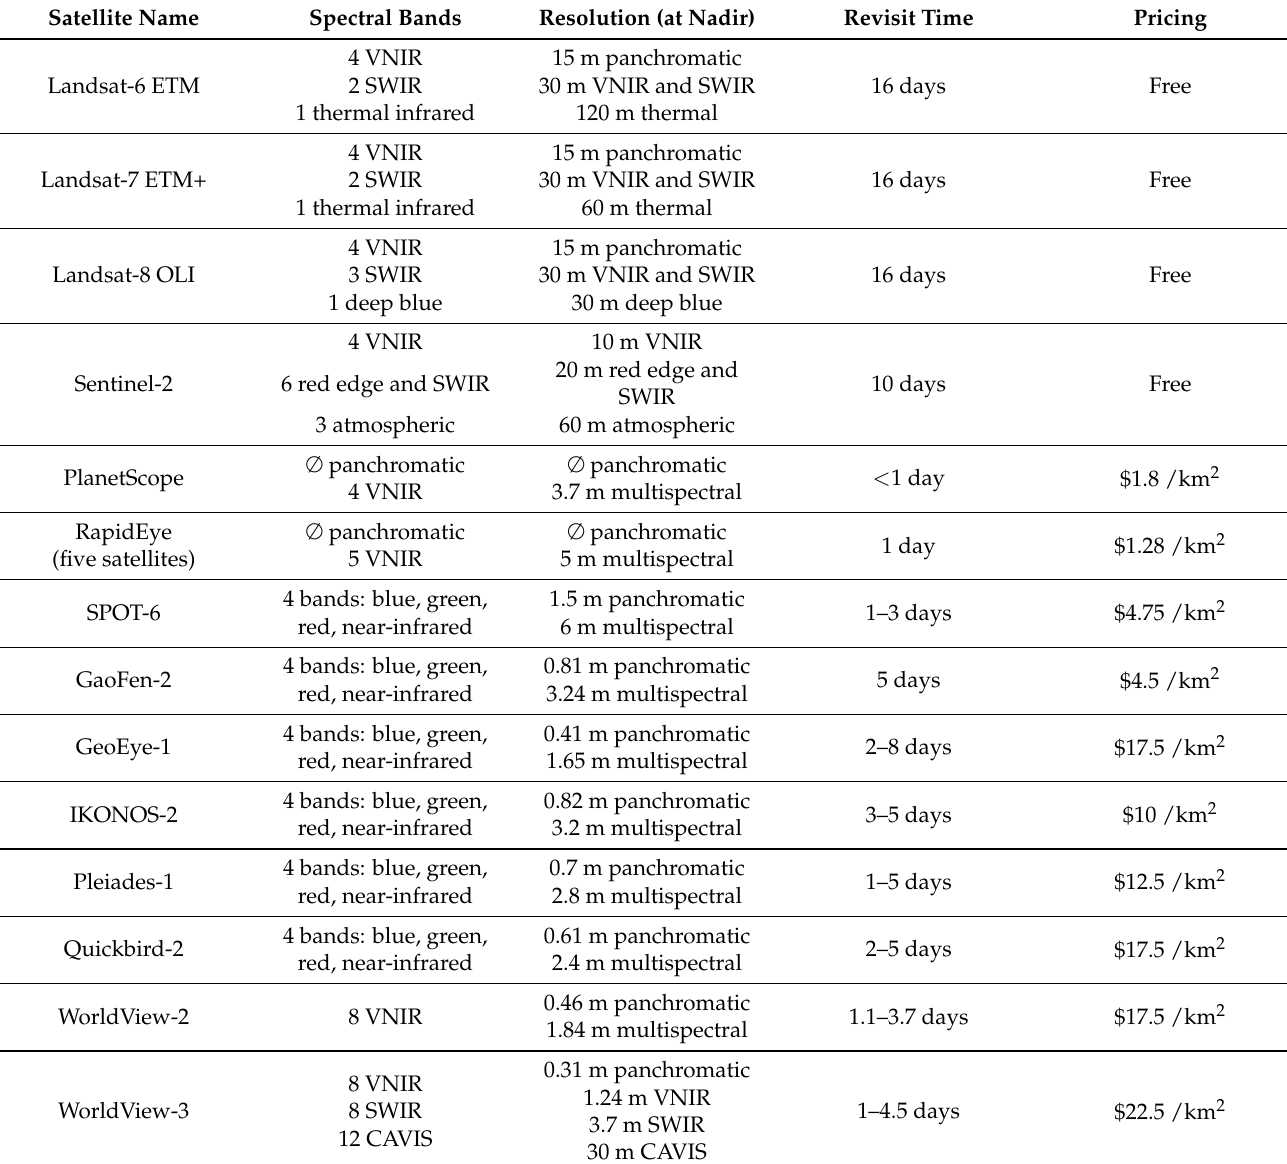
Table 1. Comparison of some characteristics of the most common multispectral satellites. Excepted for PlanetScope and RapidEye, all the satellites contain a panchromatic band which does not appear in the column “Spectral bands”. Image pricings have been recovered from the website wwww.apollomapping.com, accessed on February